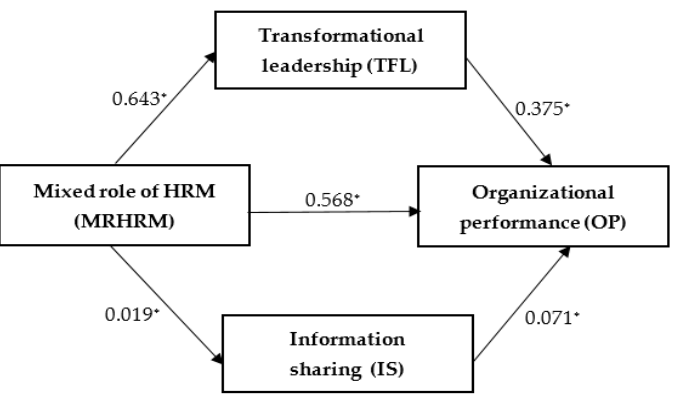
Figure 2. Estimated standardized path coefficients. Note: (*) statistically significant result at a significance level of 5%, i.e., p < 0.05.